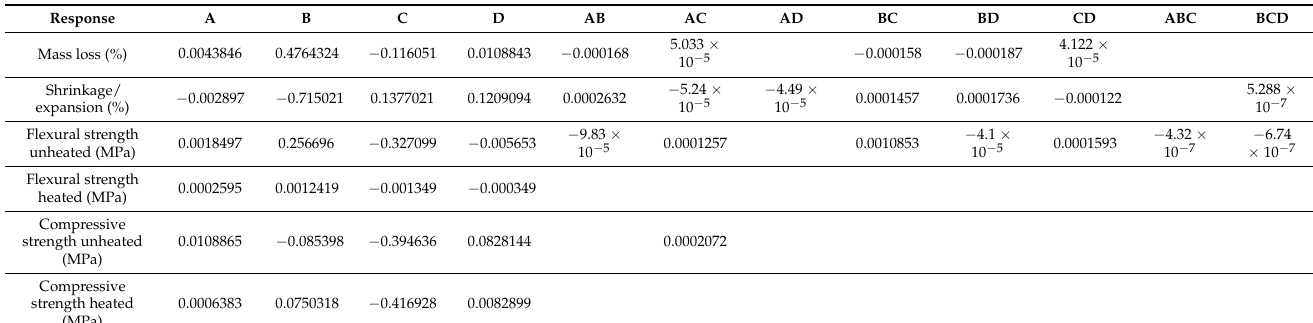
Table 5. Actual model-coded coefficients of